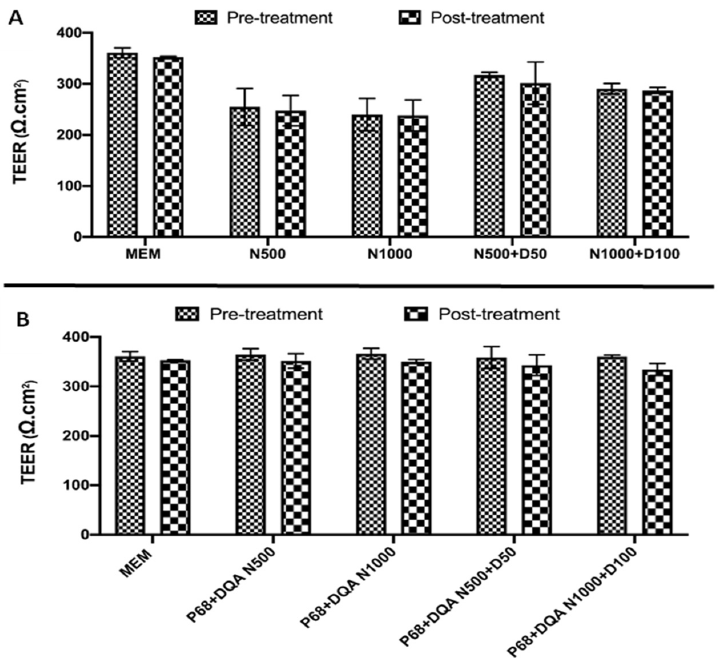
Figure 3. ( A ) Mean TEER of hCMEC/D3 cell monolayers on day 3 post seeding before (pre-treatment) and after (post-treatment) treatment with 500 µ M or 1000 µ M NAC (N500 and N1000) or the combination of 500 µ M or 1000 µ M NAC with 50 µ M or 100 µ M DFO (N500 + D50 and N1000 + D100, respectively). ( B ) Corresponding TEER results for the P68 + DQA nanoformulated NAC and NAC + DFO